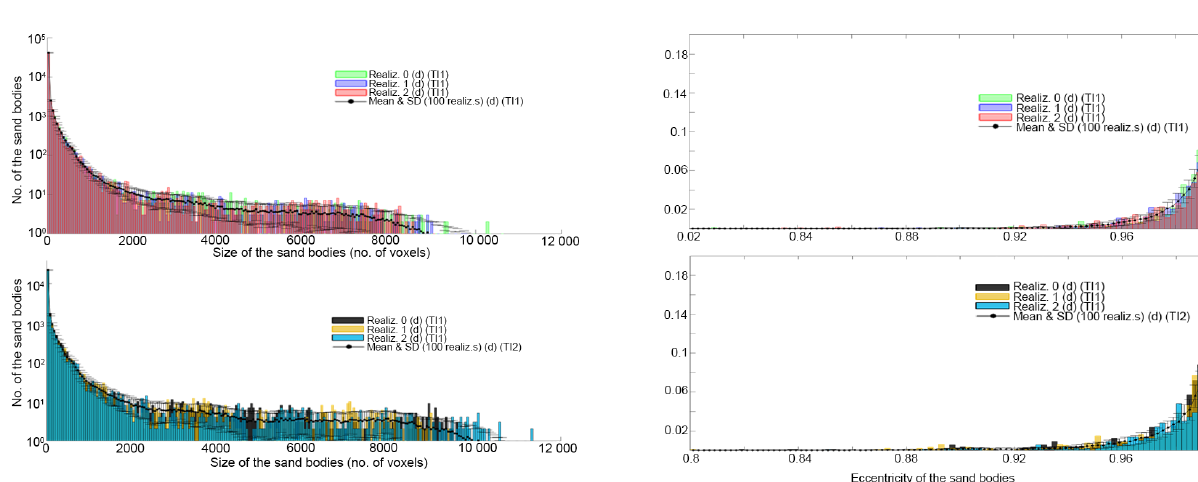
Figure A2. Probability of the eccentricity of the sand bodies (with a size larger than 1000) for the realizations obtained by using the conditioning strategy in Table 1 and respectively (a) TI1 and (b) TI2 (Fig. 10). While the histograms correspond to the first three realiza- tions, the dots and error bars represent the mean and the standard deviation obtained by using 100 realizations.